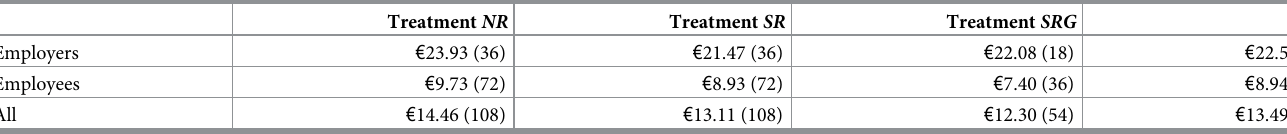
Table 2. Average payoffs by treatment and role. Numbers of participants in